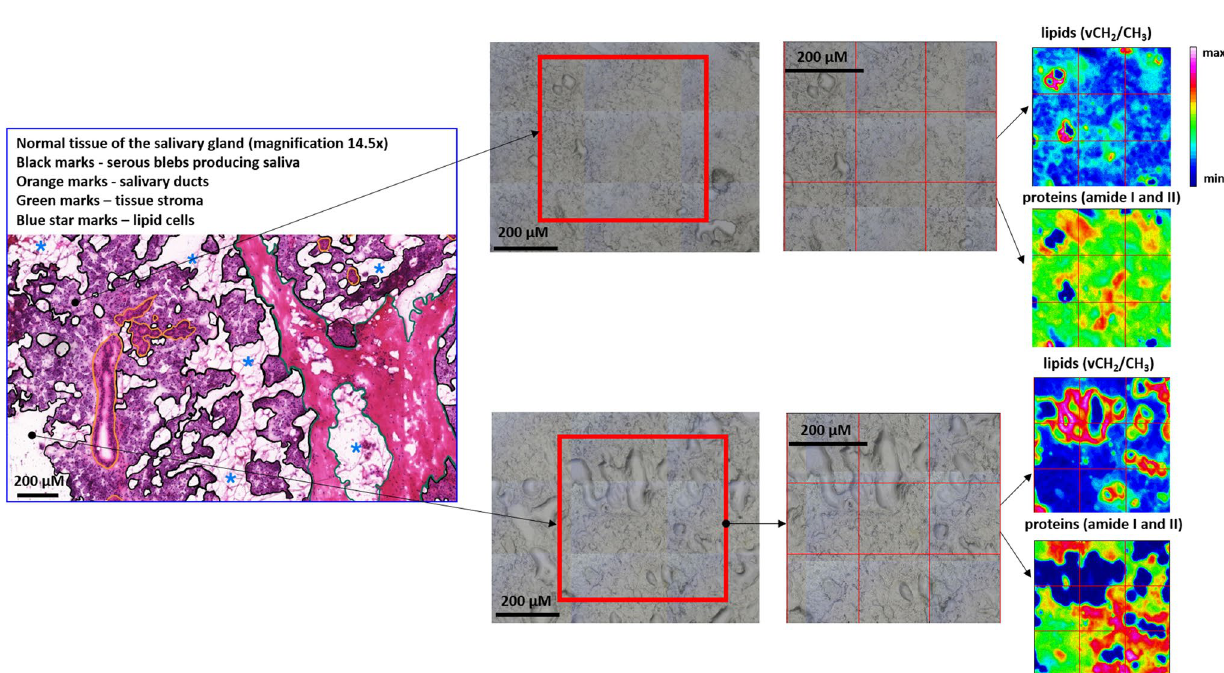
Figure 2. Exemplary microphotographs of hematoxylin and eosin (H&E) stained tissue biopsies of healthy margin, FT-IR microscope images, and FT-IR chemical maps distribution of lipids and